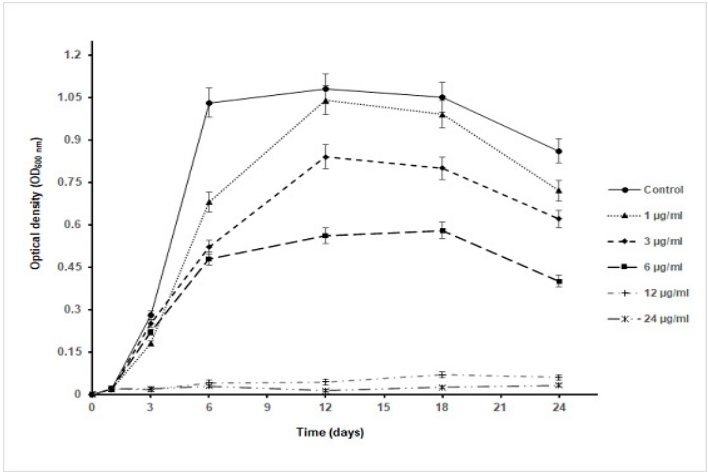
Figure 5. Growth curve of S. aureus in Muller Hinton broth containing different concentrations of AgNPs. Table 2. The effect of AgNPs on the growth kinetics of S. aureus tested bacterial strains. Concentration ( μ g/mL)